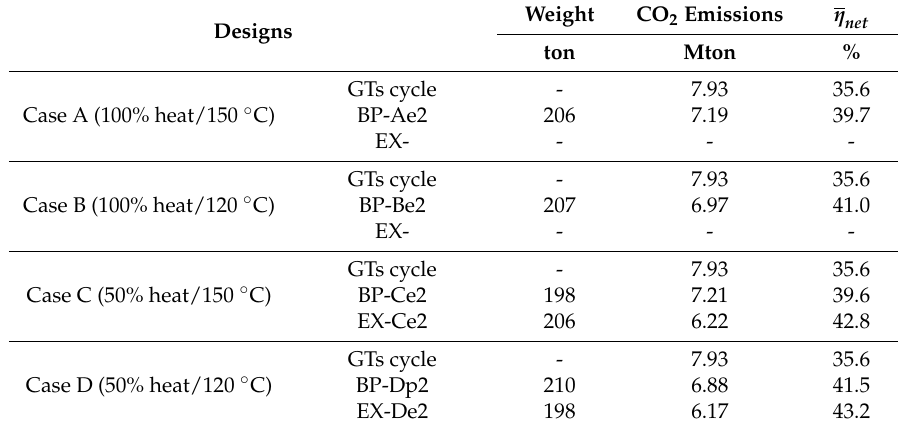
Lifetime performance of the selected designs for the different power and heat generation